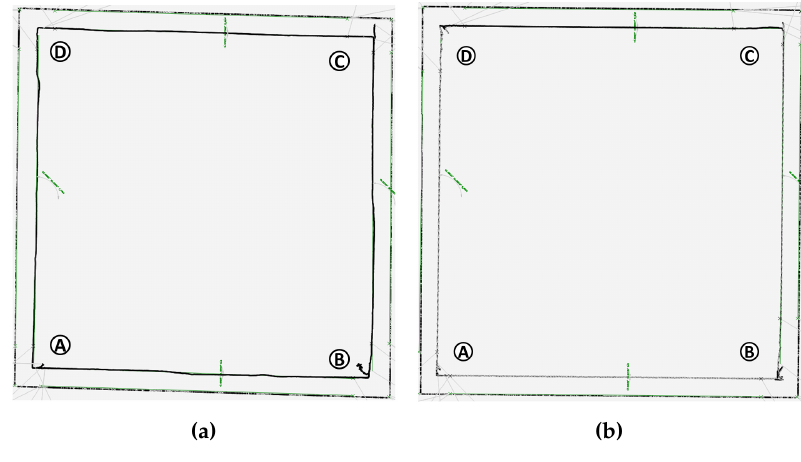
Figure 16. ( a ) Measured workpiece with automatic generated program from the planner with corners A, B, C and D; ( b ) measured workpiece without optimization following the product convention.